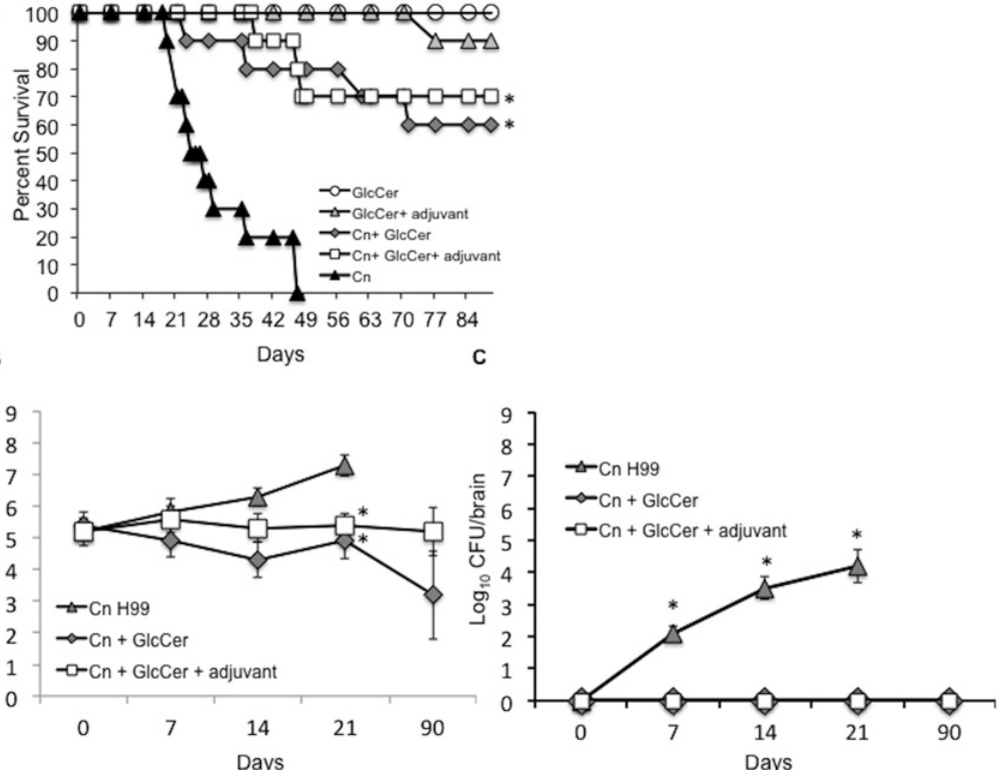
Fig 2. GlcCer administration results in partial immunity against cryptococcosis in mouse models of the disease. (A) Survival of CBA/J mice treated with 20 μ g/day of GlcCer or GlcCer + FA and infected intranasally with 5x10 5 C . neoformans (Cn) cells. The GlcCer and GlcCer + iFA control groups received treatment, but were not infected. The Cn group were infected, but did not receive treatment. Ten mice per group were used. * , P < 0 . 05 Cn + GlcCer or Cn + GlcCer + adjuvant versus Cn. (B) Fungal tissue burden in the lungs of the mice treated with 20 μ g/day of GlcCer or GlcCer + adjuvant and infected intranasally with 5x10 5 Cn. Three mice per group per day were used. * , P < 0 . 05 , Cn + GlcCer or Cn + GlcCer + adjuvant versus Cn H99 (C). Fungal tissue burden in the brains of the mice treated with 20 μ g/day of GlcCer or GlcCer + adjuvant and infected intranasally with 5x10 5 Cn. Three mice per group per day were used. Day = 0 represents the first day of infection. * , P < 0 . 05 , Cn + GlcCer or Cn + GlcCer = adjuvant versus Cn H99.